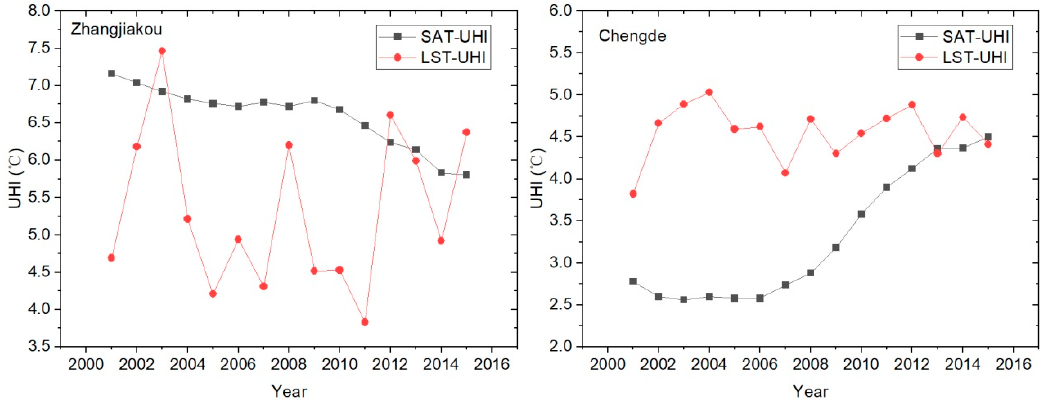
Figure 7. ( a , b ) The coefficients of variation (CV) of mean temperatures and UHI values.